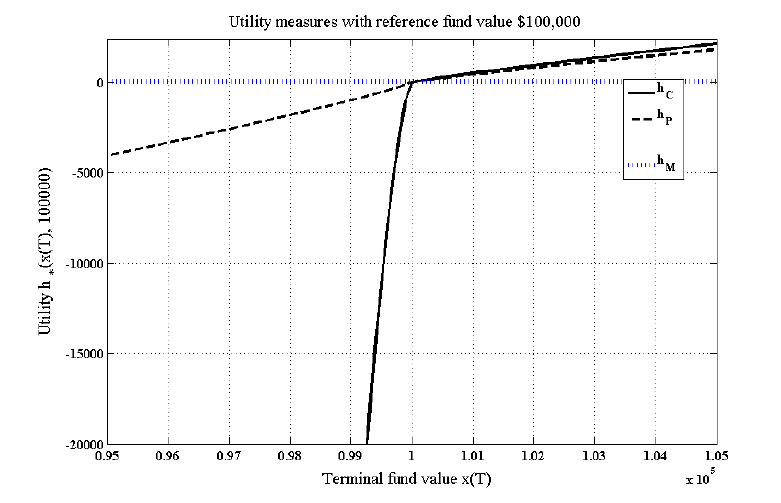
Figure 1. Risk-averse h measures for calibrated